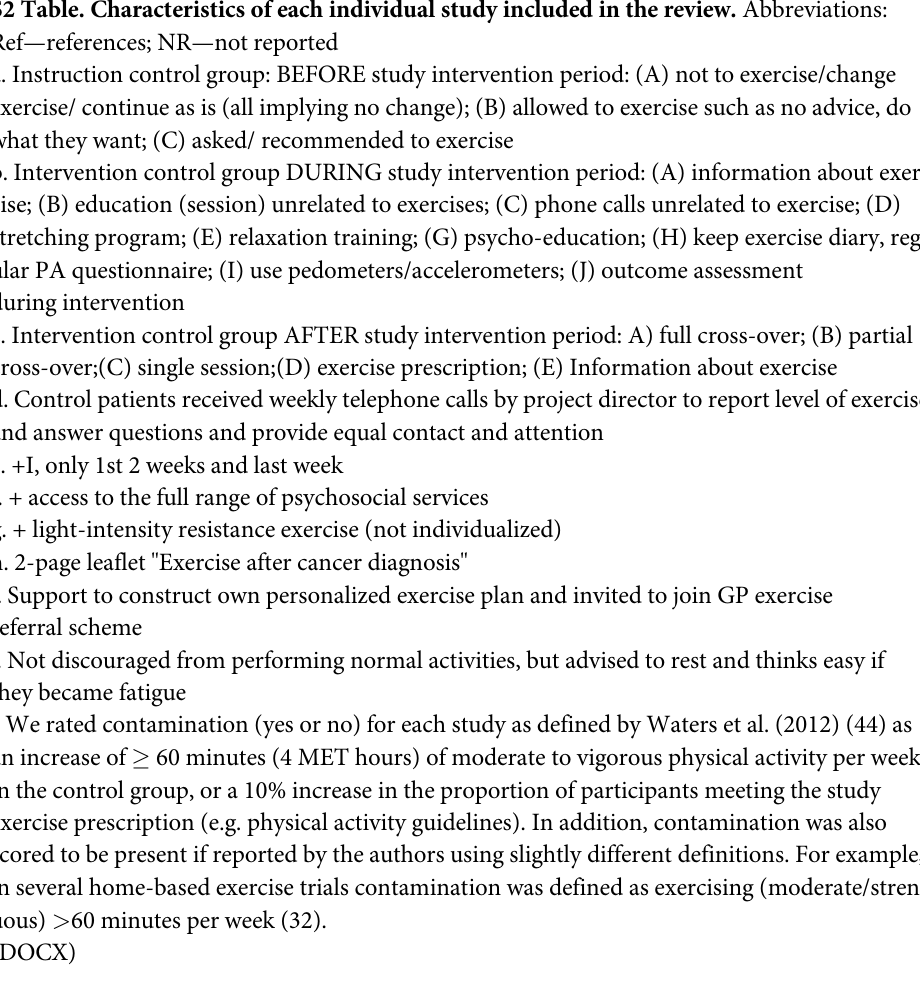
S2 Table. Characteristics of each individual study included in the review.